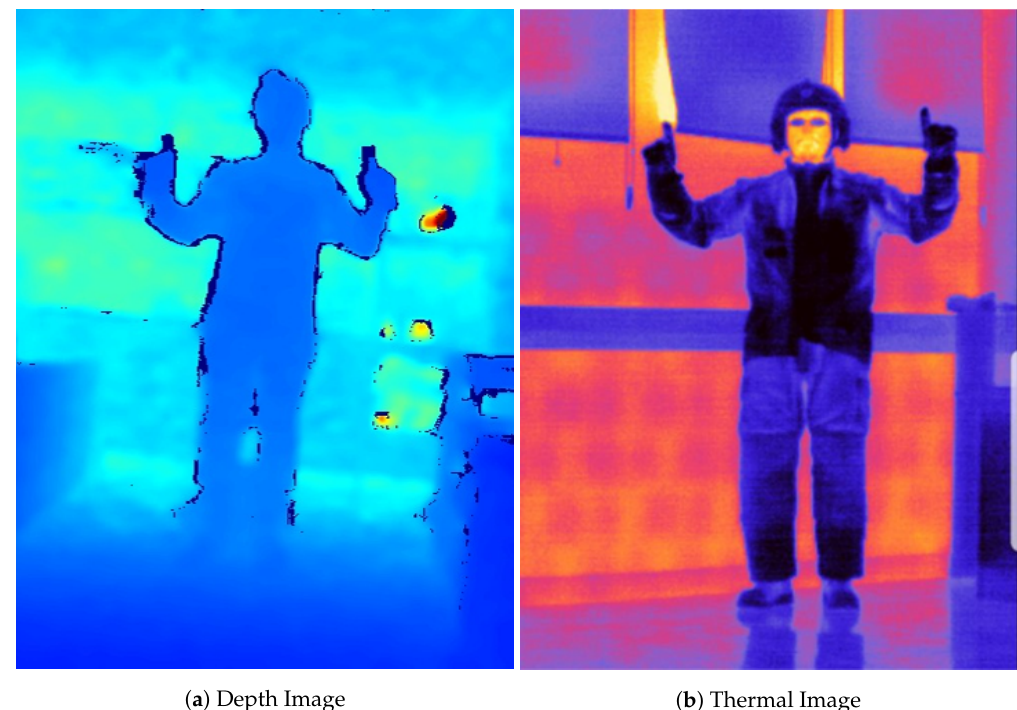
Figure 2. Example of images acquired in the evaluation phase. ( a ) Depth image of a person wearing a normal outfit. ( b ) Thermal image of a person wearing a firefighter’s protective